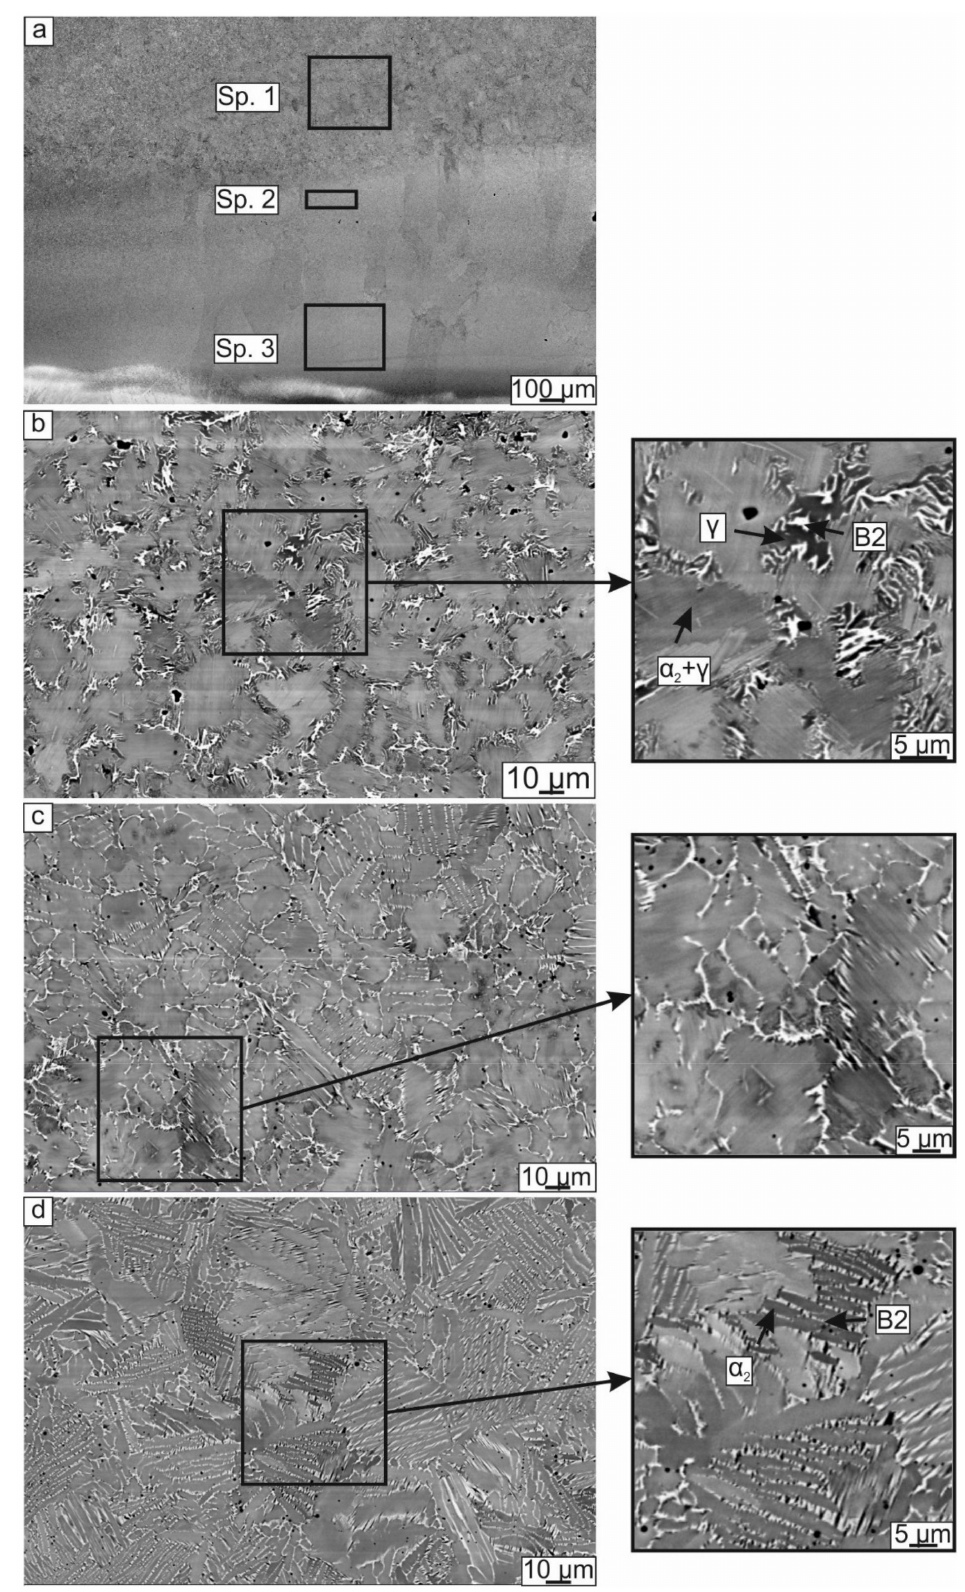
Figure 3. Microstructure of the Ti-41Al-7Cr cladding layer: ( a ) overview; ( b – d ) local areas of the cladding layer obtained in the direction from the surface of the cladding layer to the substrate. SEM images were obtained in backscattered electrons